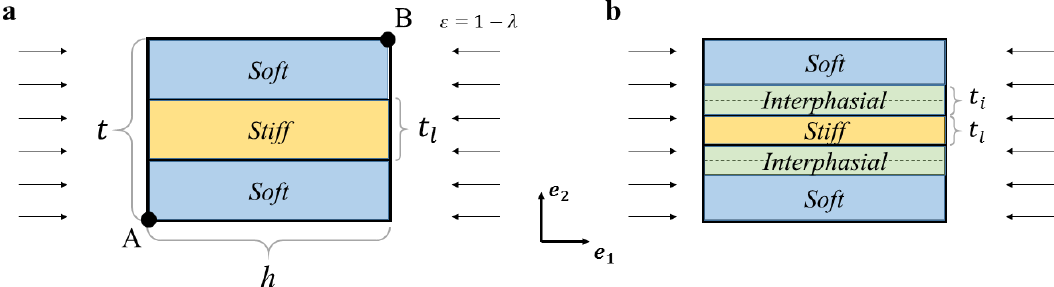
Figure 1. Unit cells of “ideal” layered composite ( a ) and “non-ideal” composite with interphasial layers ( b ).